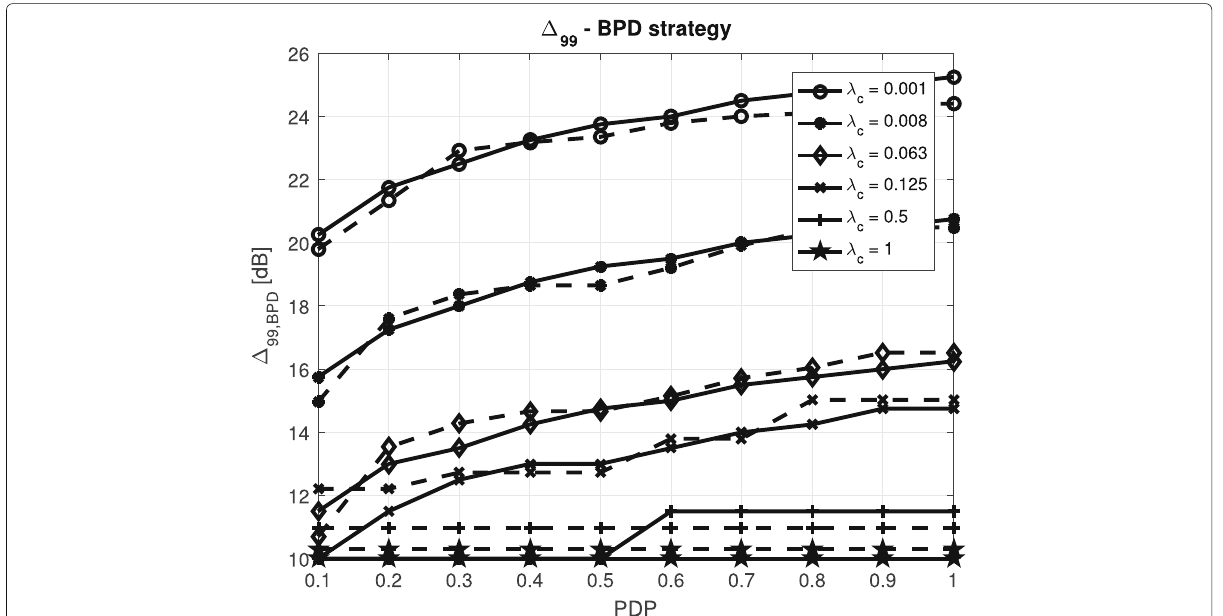
Fig. 8 Factor (cid:9) 99,BPD for frequency selective Rayleigh channel model. Factor (cid:9) 99,BPD [dB] vs. the parameter PDP for different frequency selectivity values λ C , γ E = ∞ and G ant = 40 dB. Continuous lines are derived analytically and dashed lines from